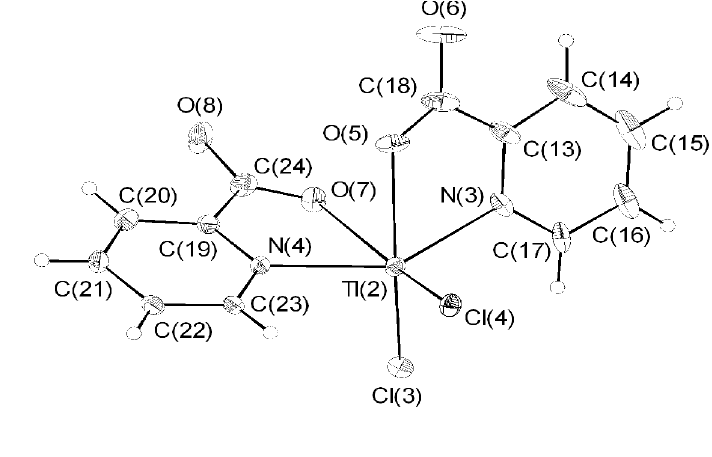
Fig. 1 ORTEP plot of the molecule 1b in [TlCl 2 (pic)(Hpic)]. The atoms are drawn with 20% probability